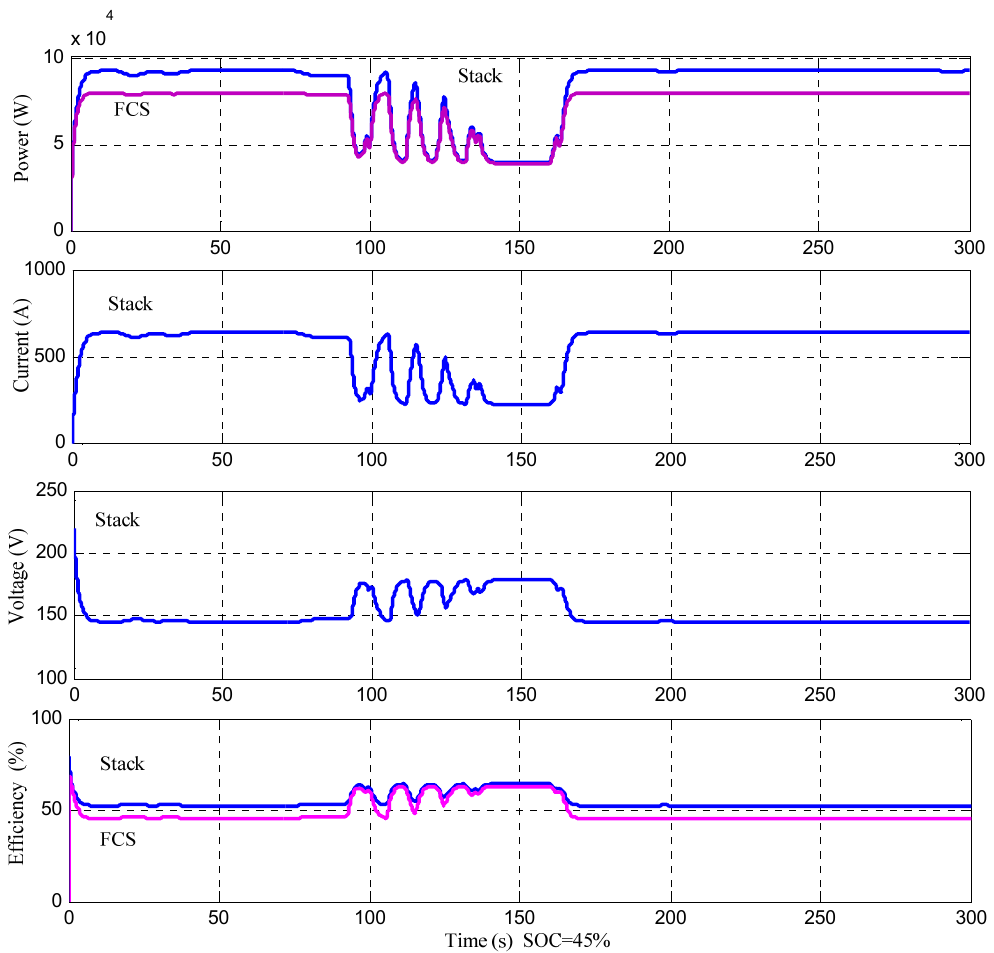
Figure 14. FC characteristics for Case